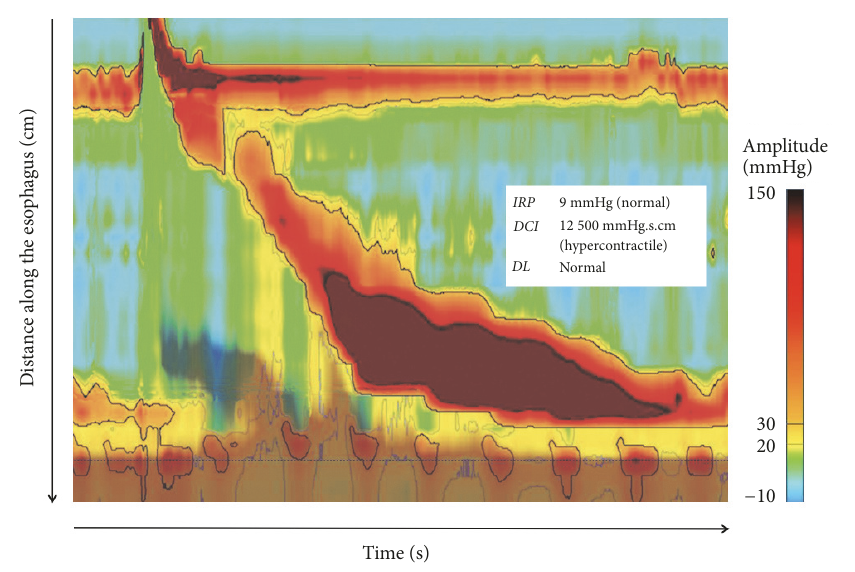
Figure 1: High resolution manometry with pressure topography of a patient with Jackhammer esophagus. This hypercontractile swallow has normal integrated relaxation pressure (IRP) and distal latency (DL), with a distal contractile integral (DCI) superior to 8 000 mmHg.s.cm.